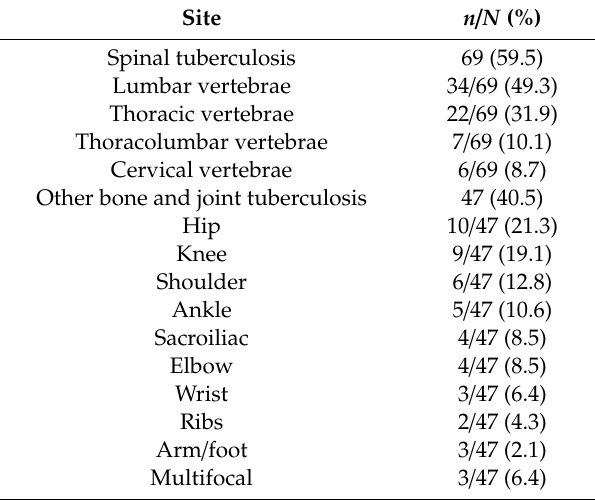
Table 2. Sites of bone and joint tuberculosis.